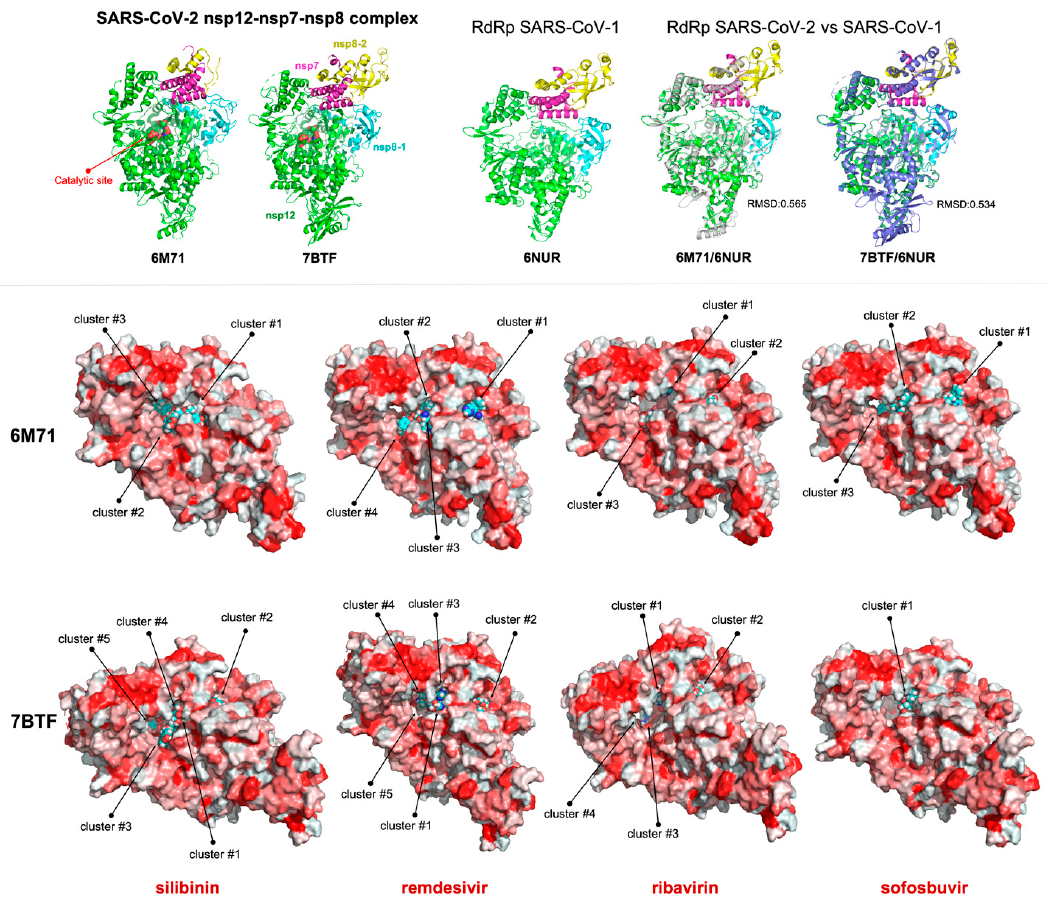
Figure 4. Silibinin is predicted to target SARS-CoV-2 viral polymerase RdRp (II). Representations of the SARS-CoV-2 viral polymerase RdRp in non-reduced (6M71) and reduced (7BTF) conditions